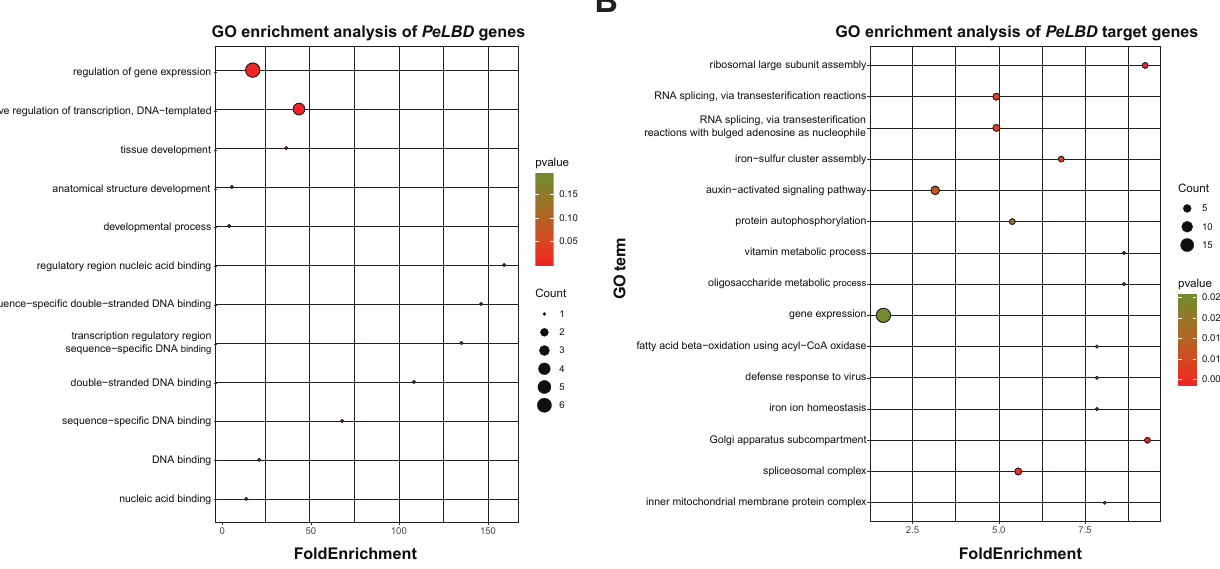
Figure 11. ( A ) Top 15 enriched GO terms for PeLBD genes; ( B ) Top 15 enriched GO terms for candidate PeLBD target genes. The horizontal axis represents the enrichment factor, and the size of the black circle indicates the number of genes annotated with a given GO term, and different colors represent p